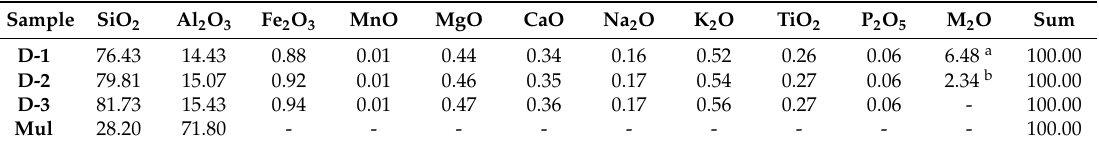
Table 4. Chemical composition of ES-NH after dehydration (D-1), de-ammoniation (D-2) and dehydroxilation (D-3), with mullite (Mul) composition calculated from the formula Al 6 Si 2 O 13 (wt %). Sample SiO 2 Al 2 O